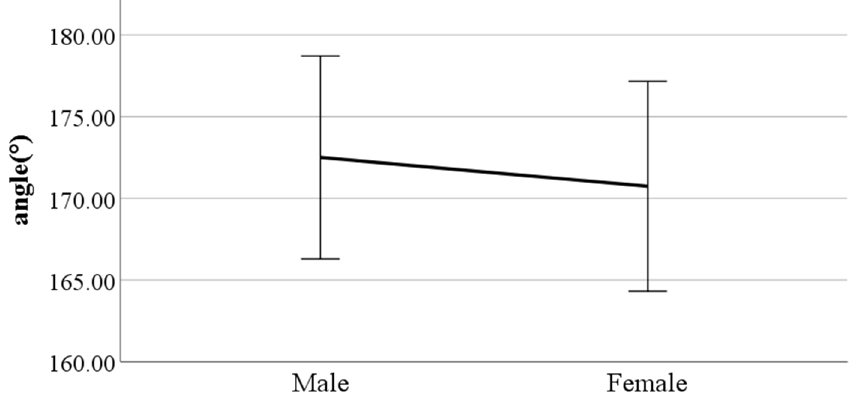
Figure 10. Gender difference in foot angle at heel-strike (F value: 0.82, DF: 289, p -value: 0.02).